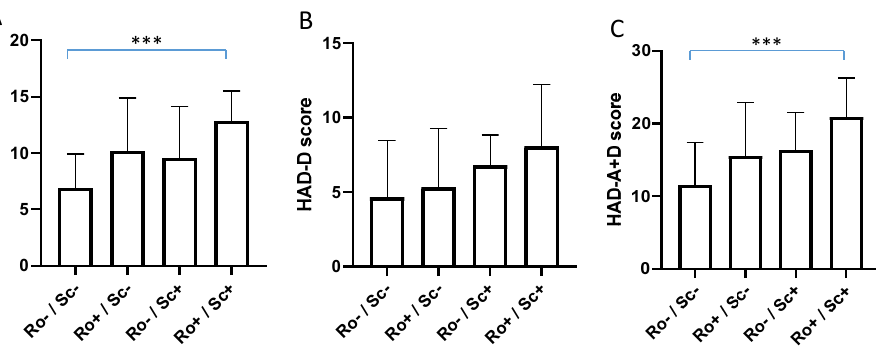
Figure 4. Response to the HAD questionnaire according to ROME-IV and SCOFF-F status combined. ***, p < 0.001 Dunn’s post-test; HAD-A: HAD-Anxiety ( A ); HAD-D: HAD-Depression ( B ); HAD A + D: HAD Anxiety and Depression ( C ); Ro+: ROME-IV positive; Ro − : ROME-IV negative; Sc+: SCOFF-F positive; Sc − : SCOFF-F negative.